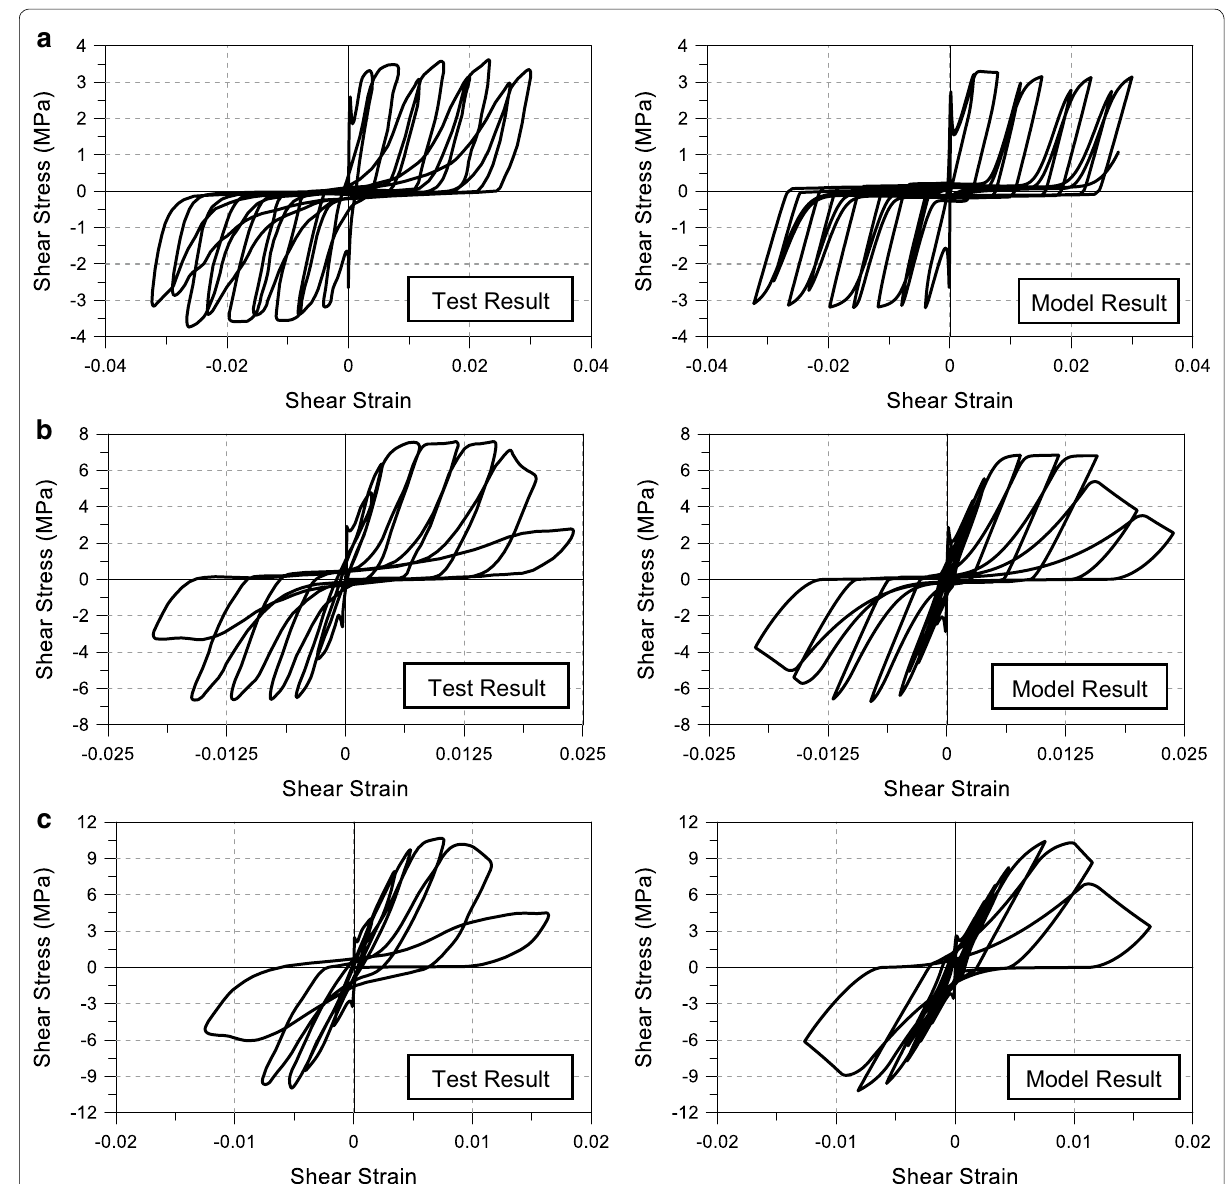
Fig. 8 Measured vs. predicted shear stress vs. shear strain responses a Specimen CA2, b Specimen CA3, c Specimen